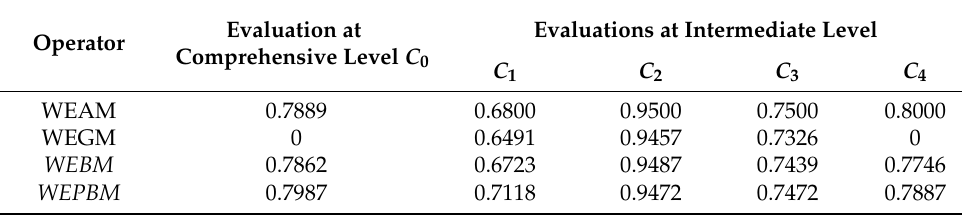
Table 3. Evaluation of the home environment based on different aggregation operators.